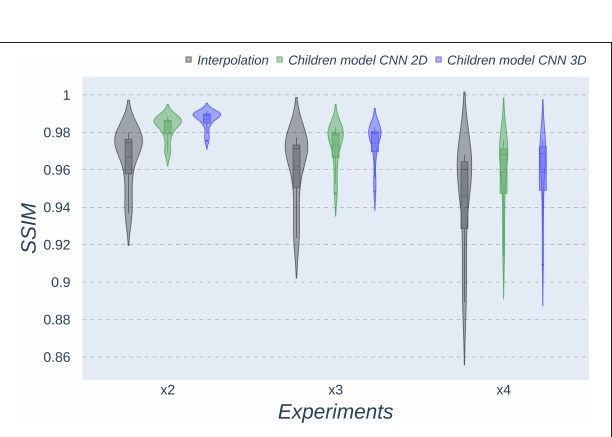
FIGURE 9 | Violin plots for SSIM metric comparing the different methods at the distinct scaling factors. Each violin plot corresponds to one specific experiment, and it is calculated from dysplasic